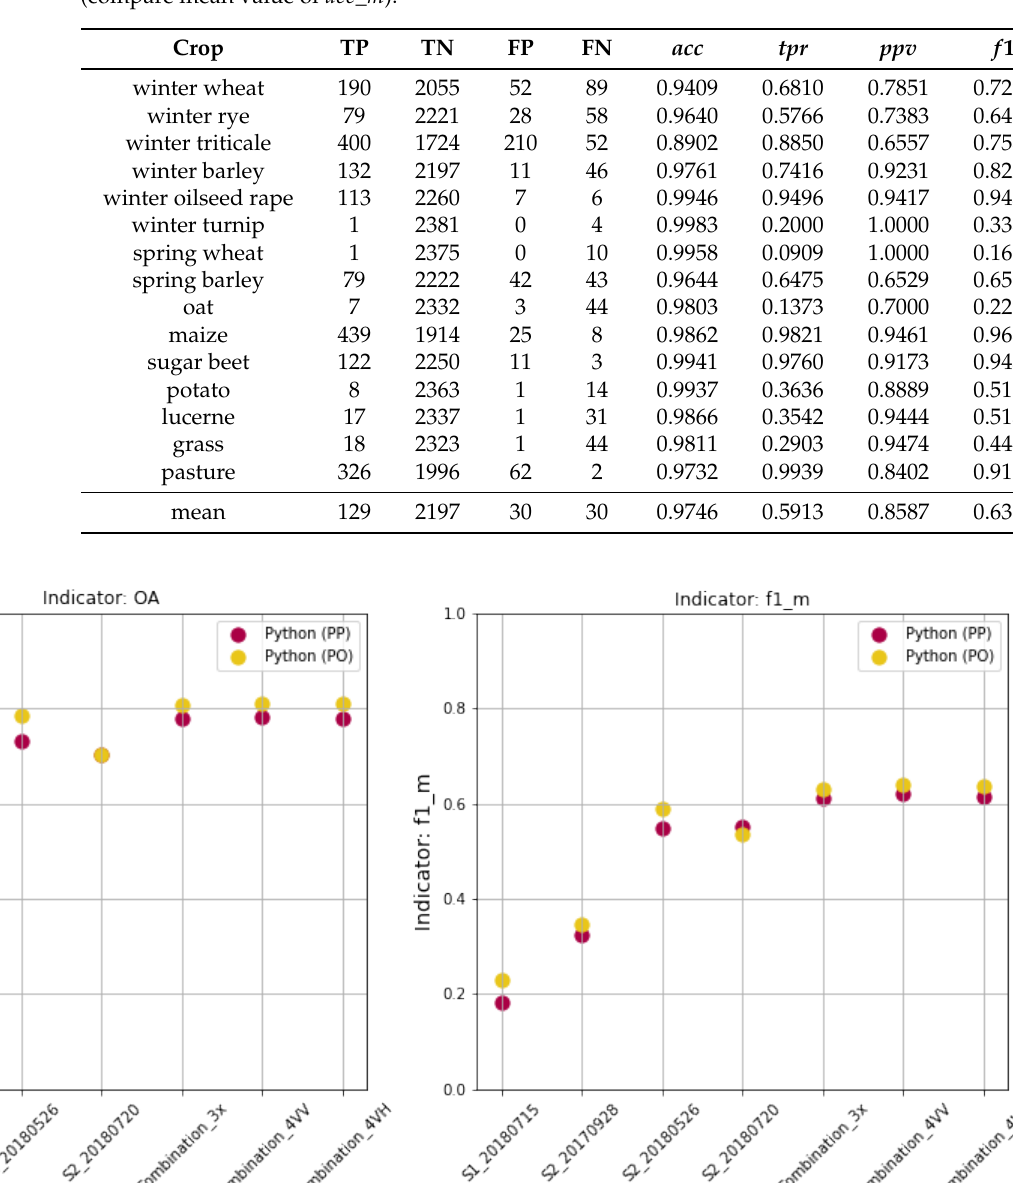
Table 11. Binary confusion matrices calculated from the full confusion matrix Table A1, OA = 0.8097 (compare mean value of acc _ m ).